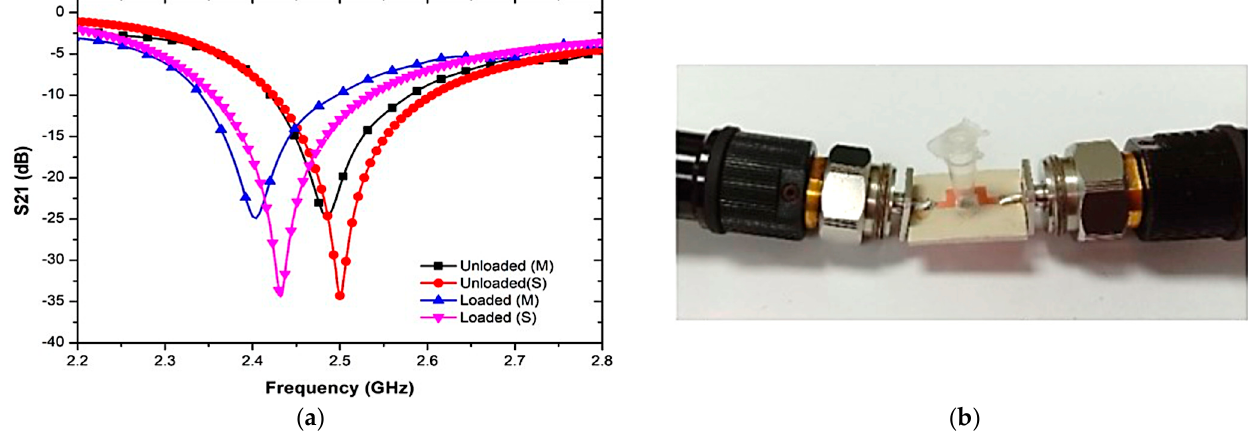
Figure 13. ( a ) Simulated and measured results of output load and unloaded tube as an empty sample (air), ( b ) PP tube loaded into triple-rings CSRR sensor. Table 4. Resonant frequency, Q — factor and S21 magnitude (dB) simulated and measured for triple- rings CSRR Sensor .